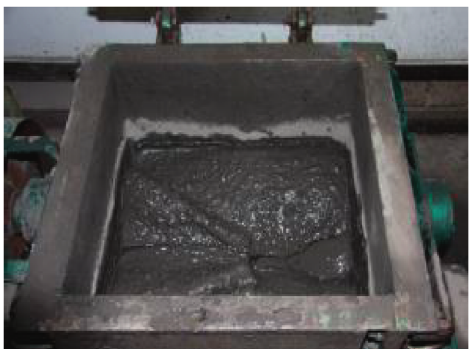
Figure 1: Mixing and preparation process of